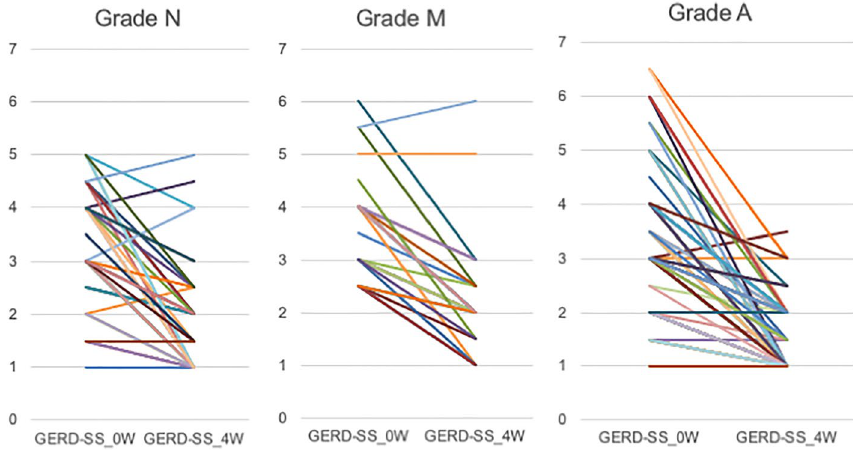
Figure 1. Changes in gastroesophageal reflux disease symptom subscale scores before and after 4 weeks of proton pump inhibitor administration.